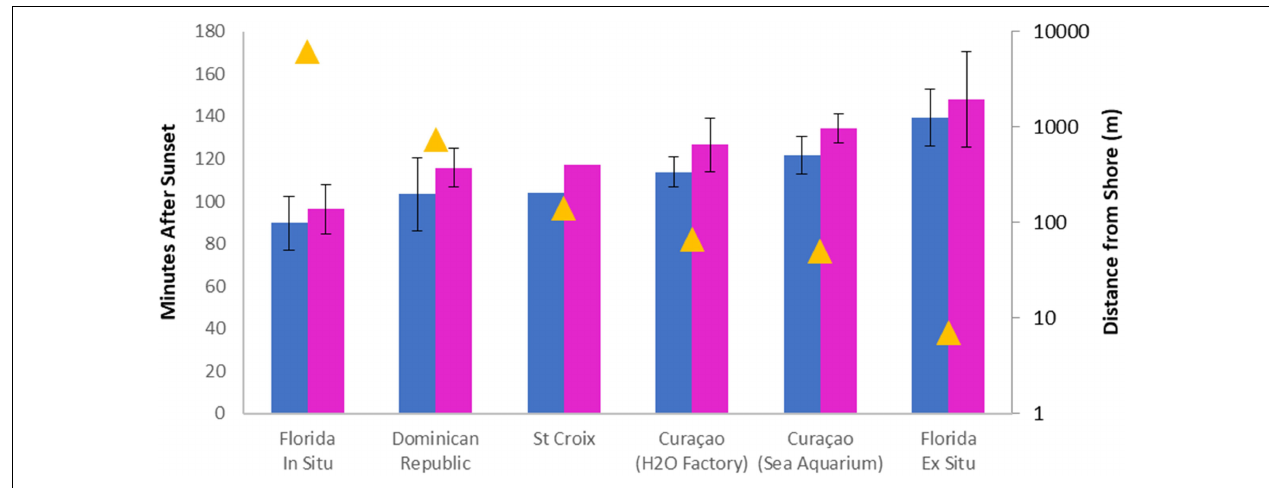
FIGURE 7 | Spawn times (minutes after sunset) of Dendrogyra cylindrus at different sites. Sexes are represented by color (males: blue, females: pink). Error bars show standard deviation. Yellow triangles represent the minimum distance of spawning sites from the nearest onshore building (note logarithmic scale). The difference in spawning time between males and females is constant across sites, but proximity to artificial lights shifts spawning times later in the night ( R 2 > 0.9, p < 0.005).